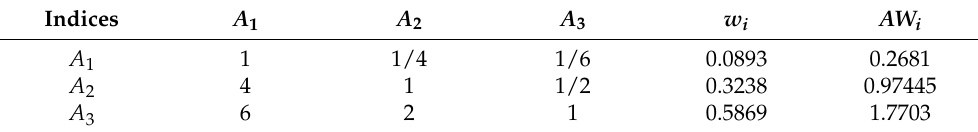
Table 3. The Matrix Between The Three Indices.